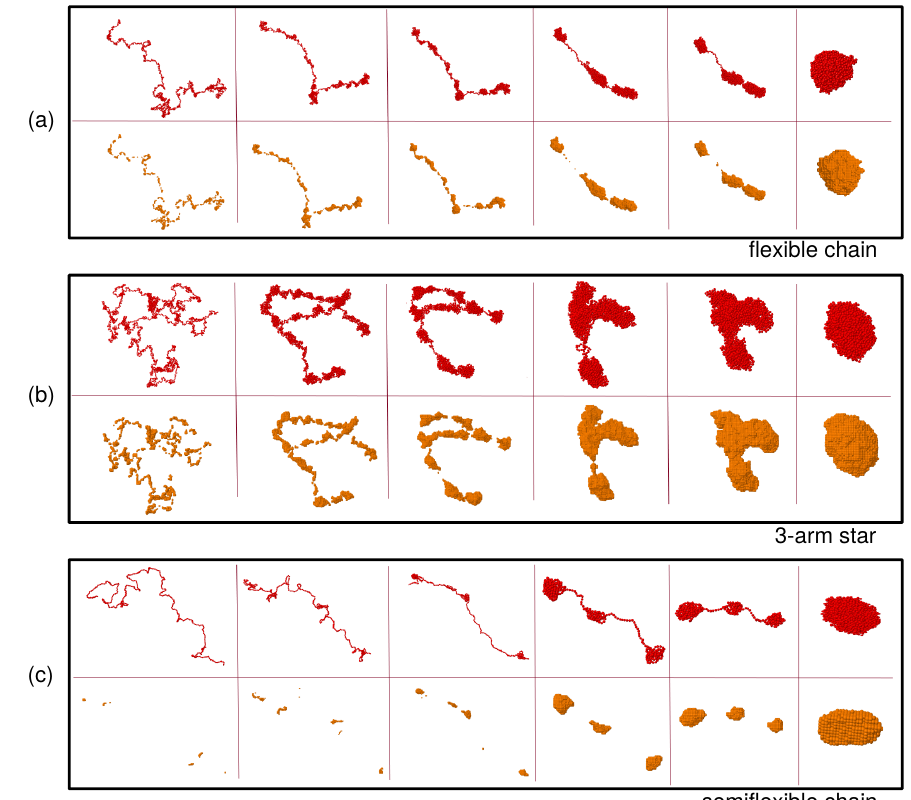
Figure 1. Snapshots of real (red beads) and density field (orange beads) coordinates of the flexible linear chain ( a ), the three-arm star ( b ) and the semiflexible linear chain ( c ). In all cases the collapse occurs at solvent parameter φ = 1.2, and the parameters r c = 1.0 and ρ min = 0.6 are used to construct the density field. The times for each panel are, from left to right: t = 5, 50, 126, 251, 316, 1000 (( a ) and ( b )), and t = 5, 50, 126, 398, 500, 8000 ( c